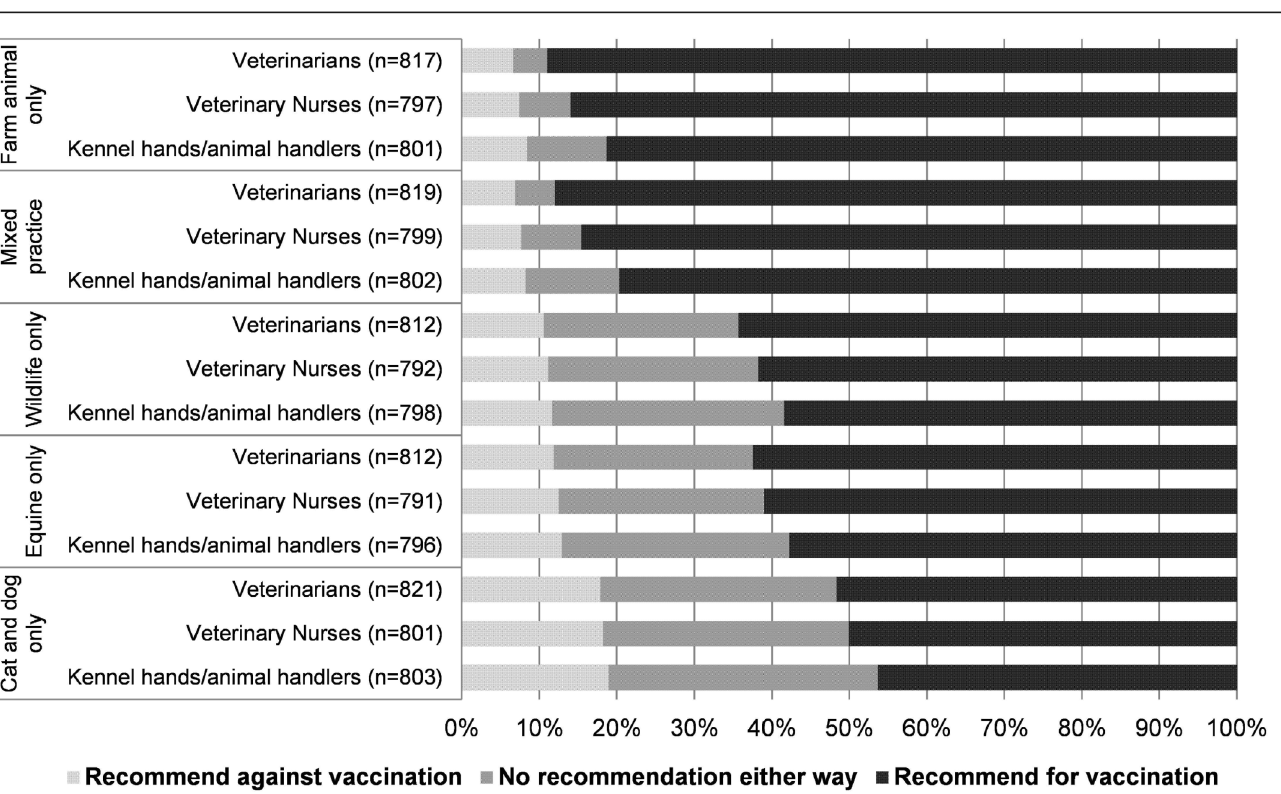
PLOS ONE | https://doi.org/10.1371/journal.pone.0198421 June 1,